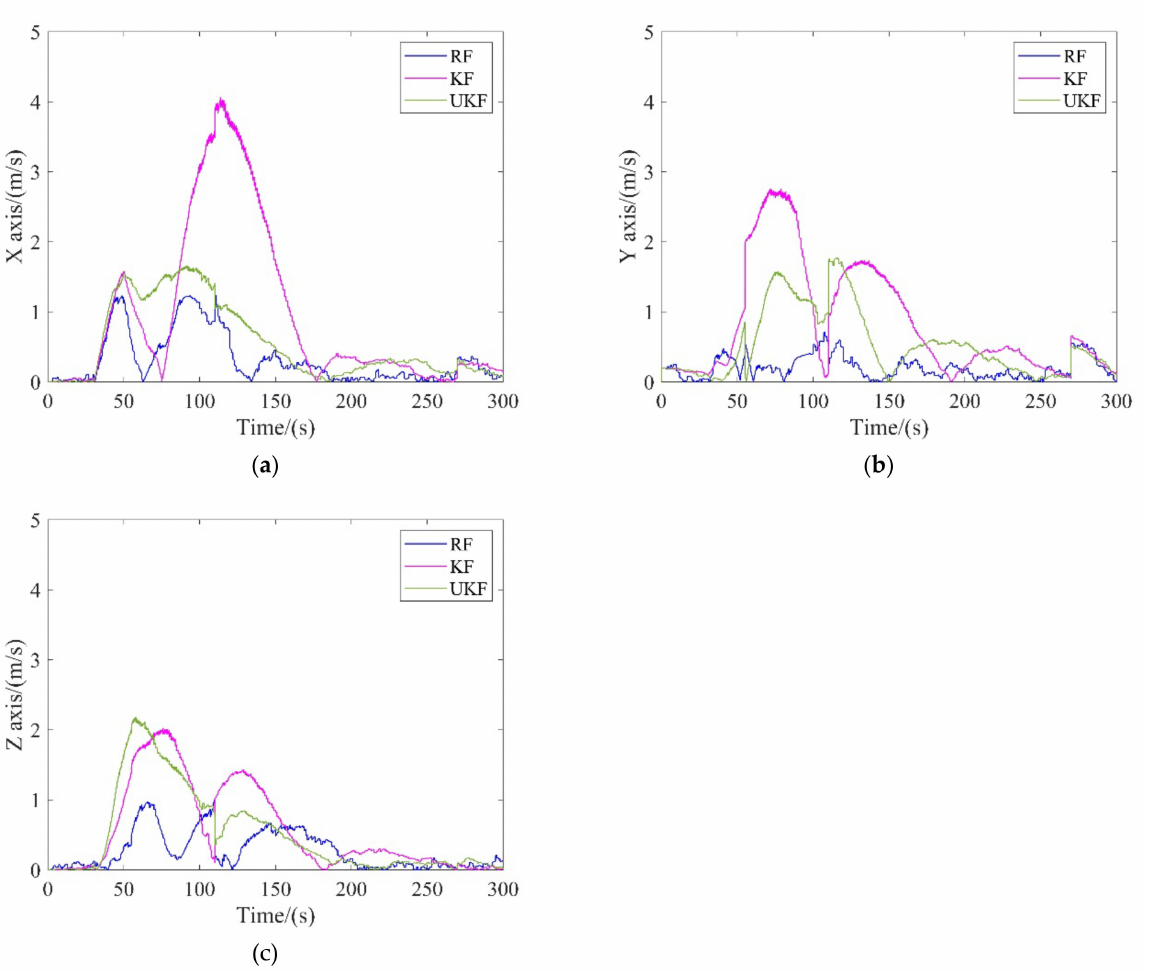
Figure 8. ( a ) X -axis velocity error contrast curves; ( b ) Y -axis velocity error contrast curves; ( c ) Z -axis velocity error contrast curves. Velocity error contrast curves under the launch inertial coordinate